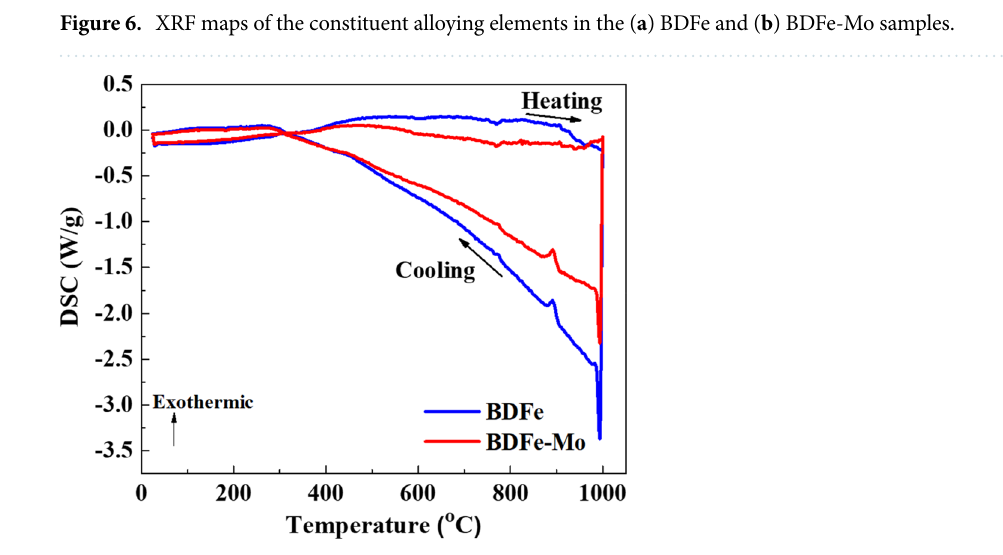
Figure 7. DSC curves of the two BDFe powders during continuous heating and